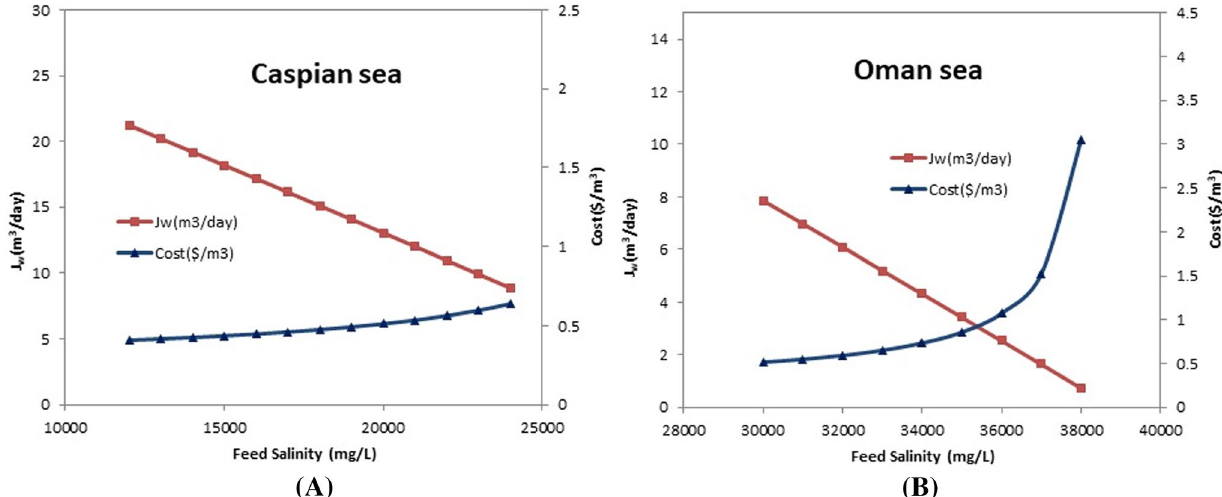
Fig.6 Evaluating the effect of the feed water salinity on the cost and the permeate flow rate (Δ P = 45 bar, T = 25 °C, R